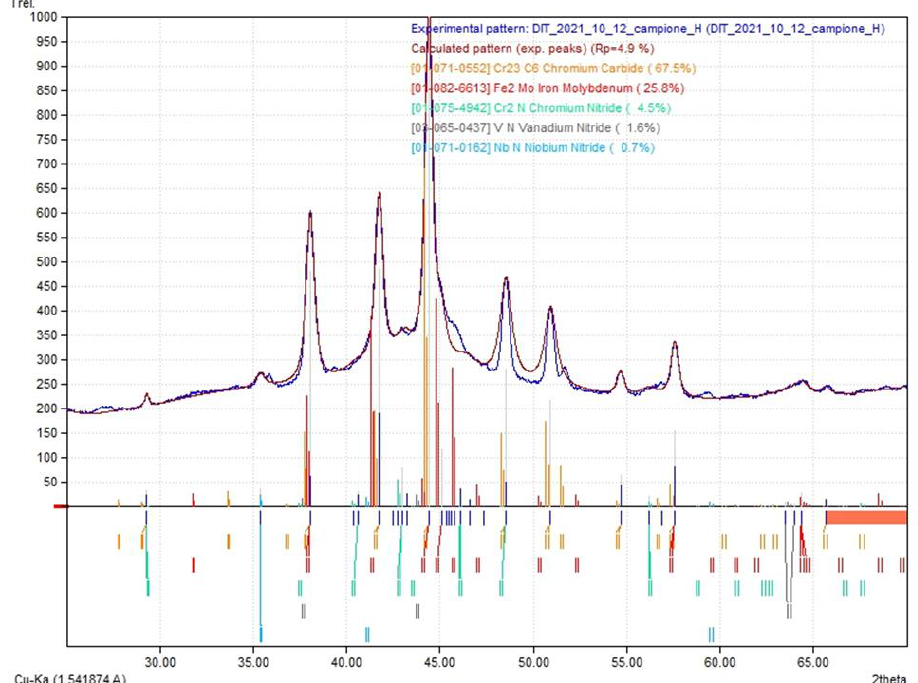
Figure A11. Failed crept cross-weld specimen 92-HAZ-6-6 650 °C 65 MPa 3877 h (sample H). XRD analysis.